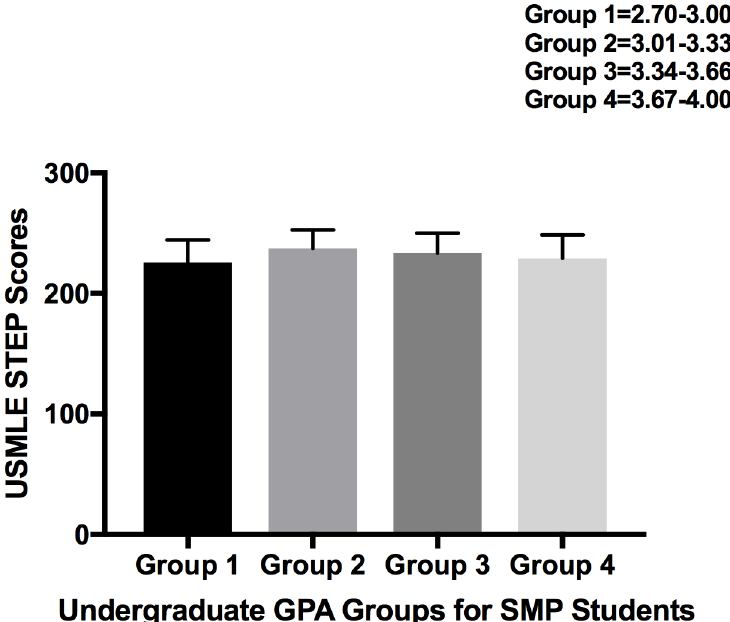
Fig 3. Comparative analysis of USMLE STEP 1 scores relative to undergraduate GPAs of SMP students. SMP students are categorized into 5 groupsbased on undergraduate GPA scores (Group 1 = 2.70–3.00,Group 2 = 3.00–3.33,Group 3 = 3.34–3.66, Group 4 = 3.67–4.00) and comparative analysis was performed using One-way ANOVA with Tukey Kramer Post-hoc